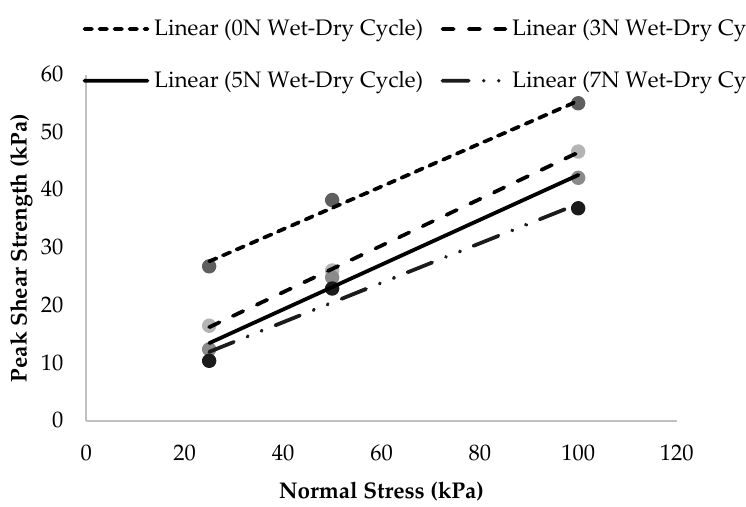
Figure 7. Mohr-coulomb failure envelopes of the samples subjected to different wet-dry cycles.